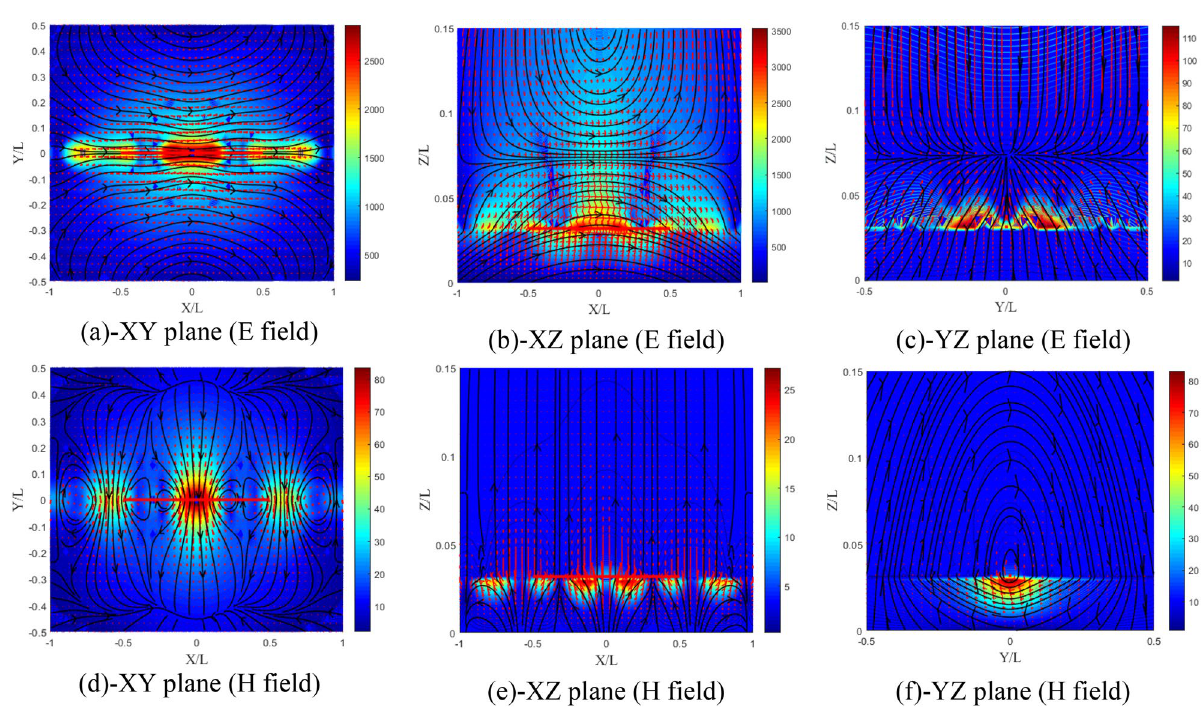
0.5 ) case, ( a – c ) electric η xy = = −